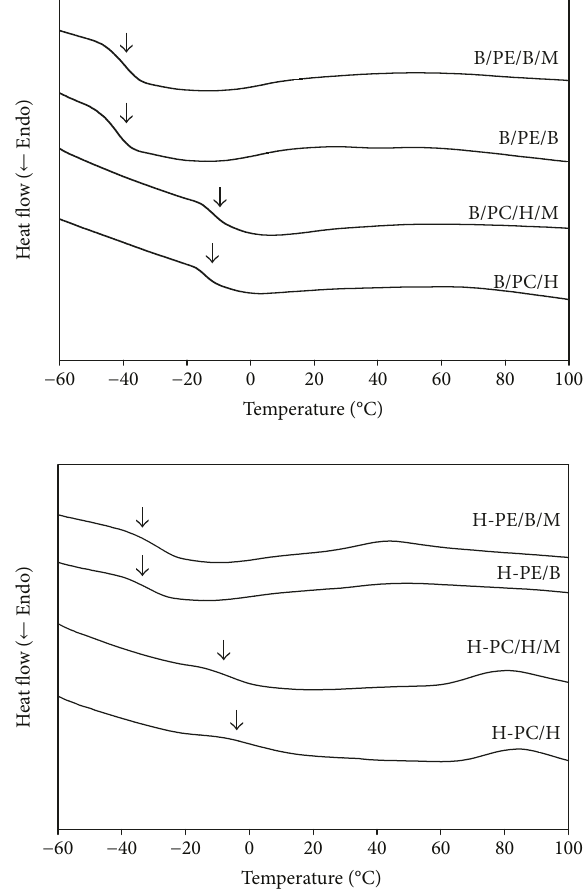
Figure 3: DSC thermograms of polyurethane fi lms.